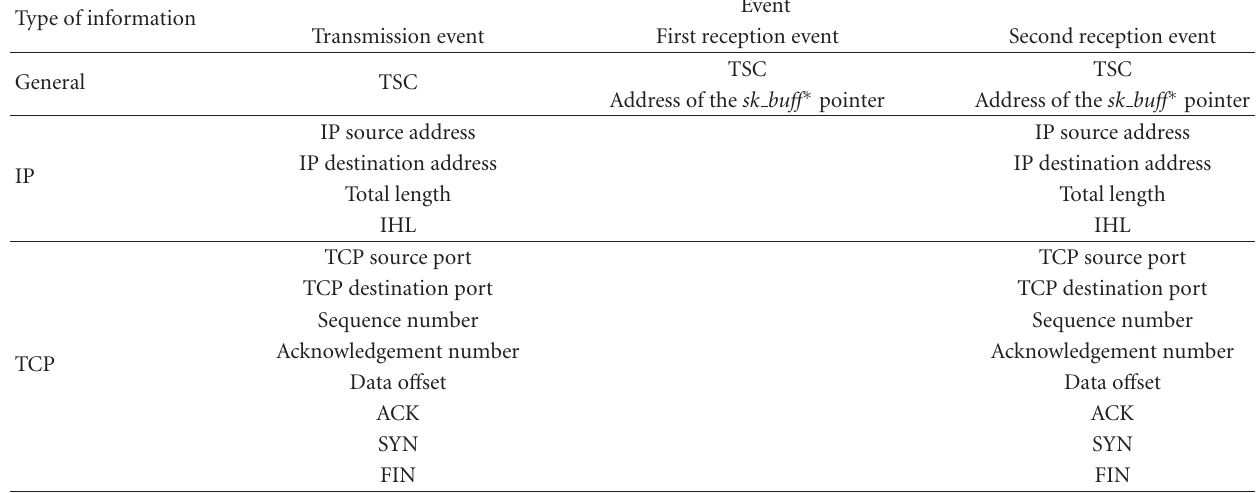
Table 1: Information traced for each event.